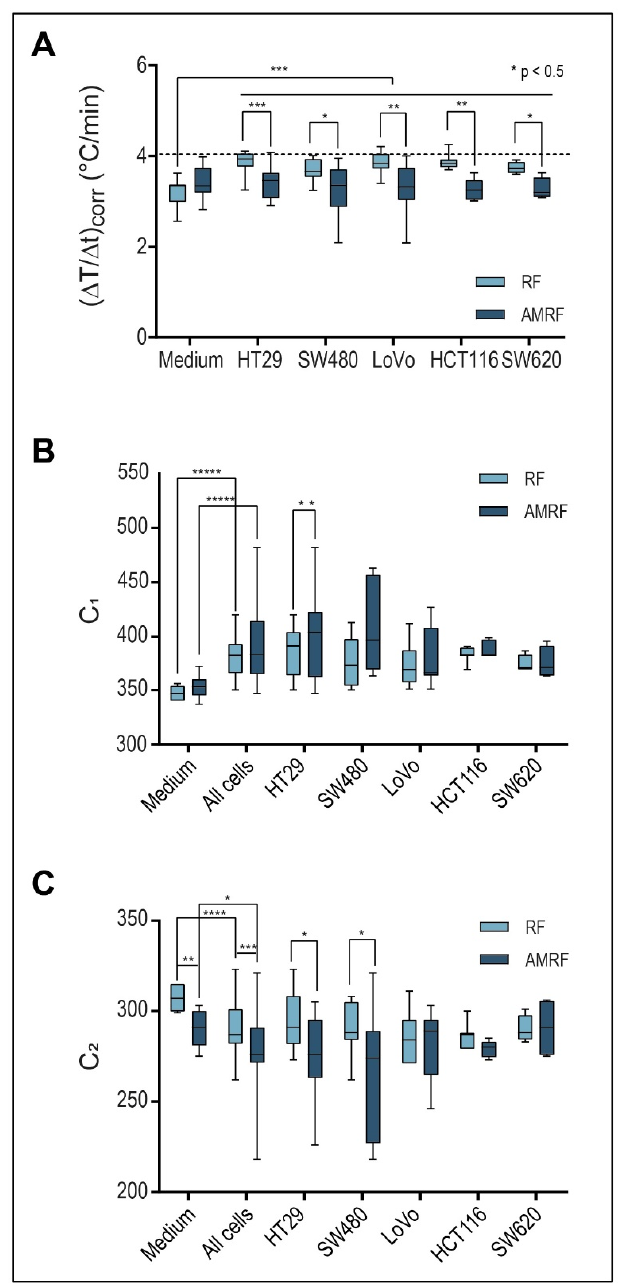
Figure 3. ( A ) Power deposition; Detected temperature gradients after radiation onset in the in vitro applicator (10 W with flow, ± AM with ≥ 100 Hz), which are significantly higher for RF in all cell suspensions than in the medium. For RPMI medium, a slight nonsignificant increase is observed for AMRF versus RF. In contrast, for each cell line, a significantly lower value is observed (significance level is shown above the bars: p < 0.05 and marked with *, < 0.005 with **, etc.). The dashed line marks the medium level for RF. ( B ) Tuning capacitance C 1 ; C 1 of the in vitro applicator for medium and five cell lines exposed to RF or AMRF radiation. Differences are evident between medium and cell suspensions and between RF and AMRF—in particular, after pooling the cells. Individual cell lines appear to follow a trend. C 1 is higher when using AMRF instead of RF. The difference is lowest for the cell lines (LoVo, SW620, and HCT116). ( C ) Tuning capacitance C 2 ; C 2 of the in vitro applicator for medium and five cell lines exposed to RF or AMRF radiation. Differences occur similar to C 1 , but C 2 values are lower for AMRF than for RF. Again, this difference is lowest for the cell lines (LoVo, SW620, and HCT116).